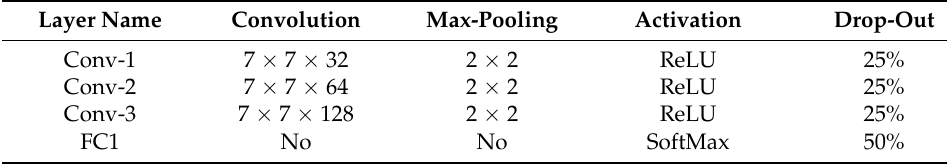
Table 1. A summary of models’ architecture and